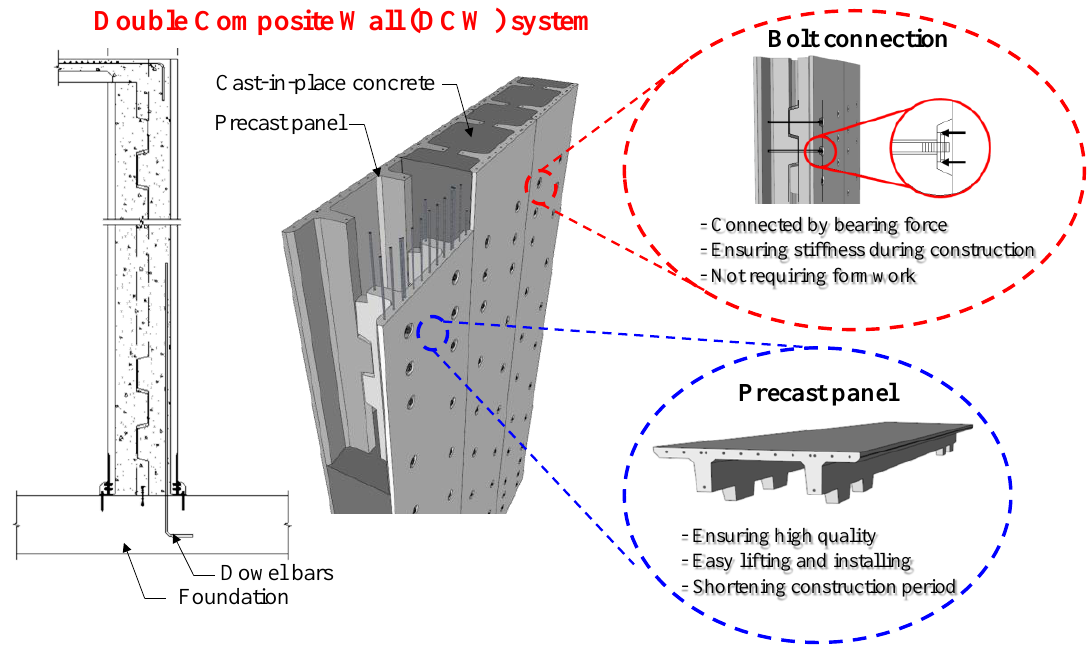
Figure 1. Characteristics of the double composite wall (DCW) system.